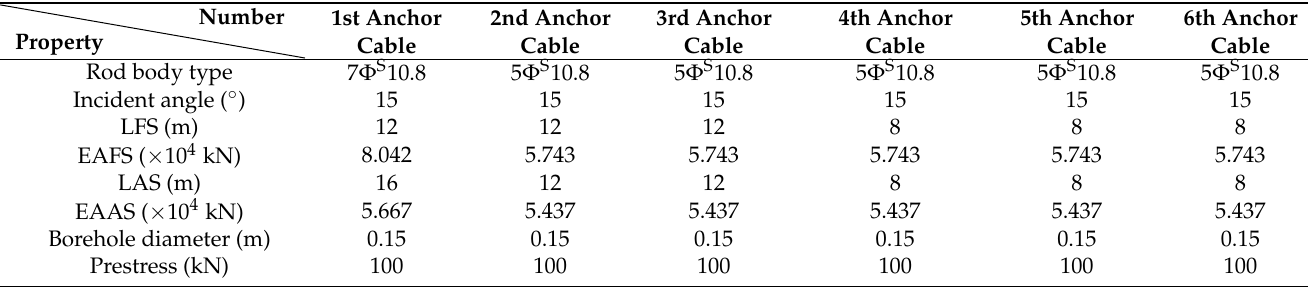
Table 5. Main parameters of prestressed anchor